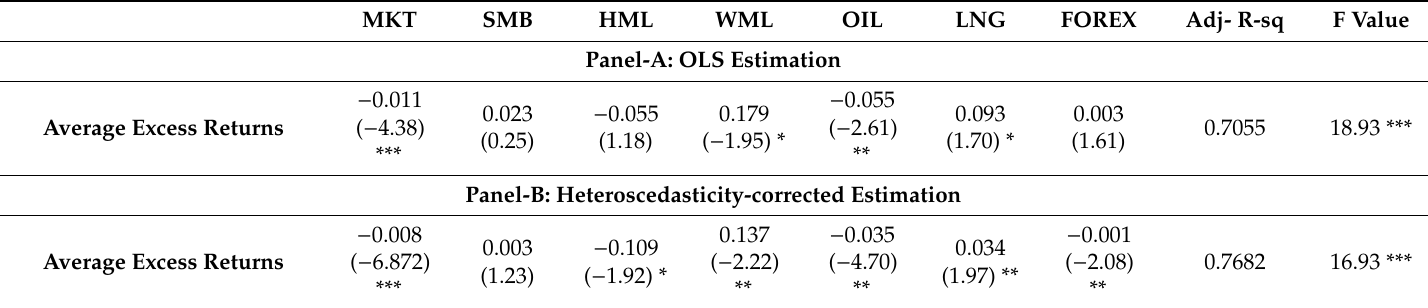
Table 7. Results of Cross-sectional Regression of Downside Risk Exposure on Average Excess